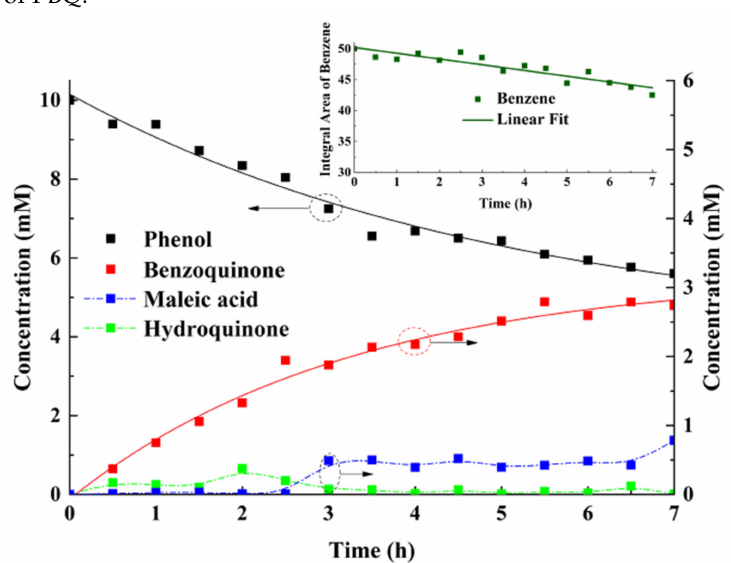
Figure 5. Evolution of concentrations of the reagent and products during the EAOPs for phenol in an in situ EC-qNMR cell. The reagent is phenol. The products are benzoquinone, hydroquinone, and maleic acid. Inset shows the integral area of benzene (standard sample) and its linear fitting